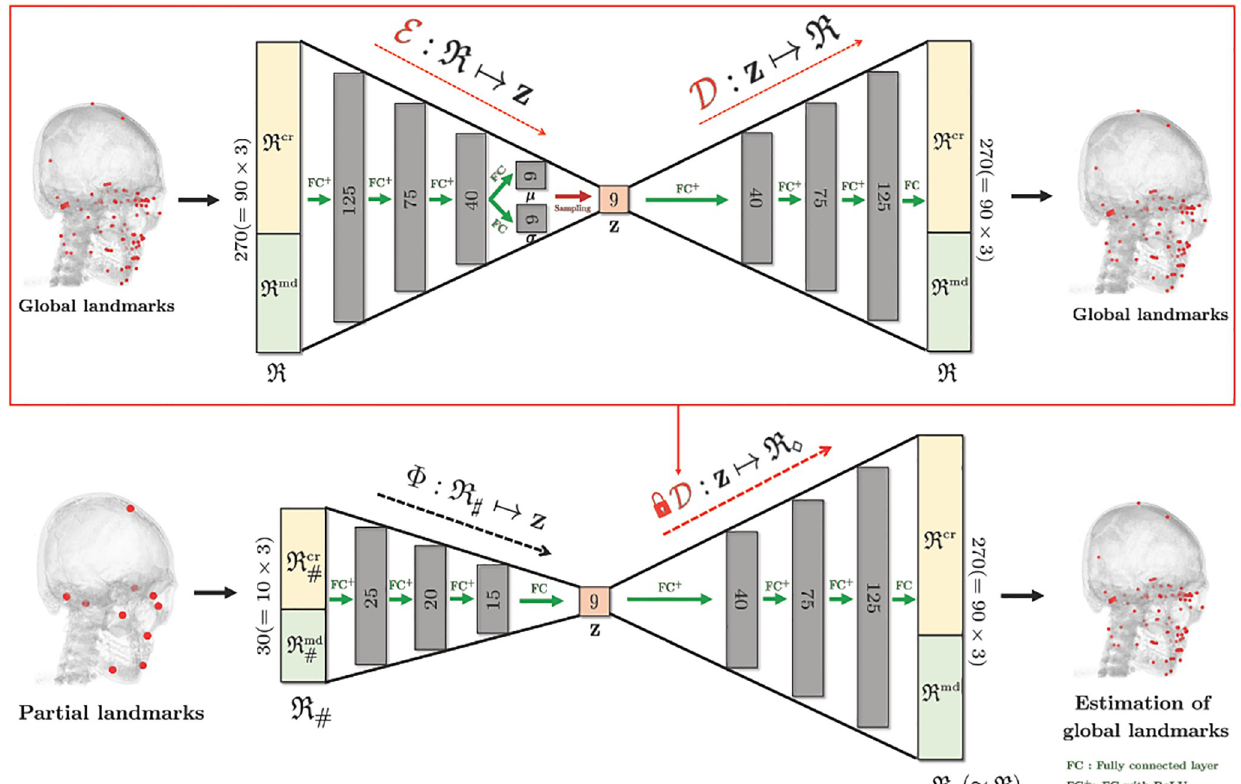
Fig 3. Initial estimation of all 90 landmarks R using the knowledge of 10 reference landmarks R roughly represented by only 9 latent